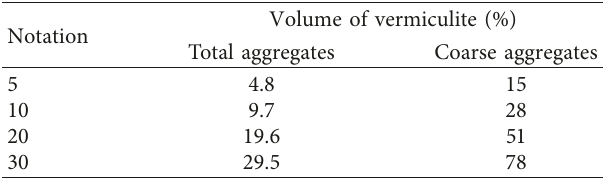
Figure 2: Thermal molding method: two-dimensional heat flow. Table 6: Total volume fraction of vermiculate with respect to aggregates.